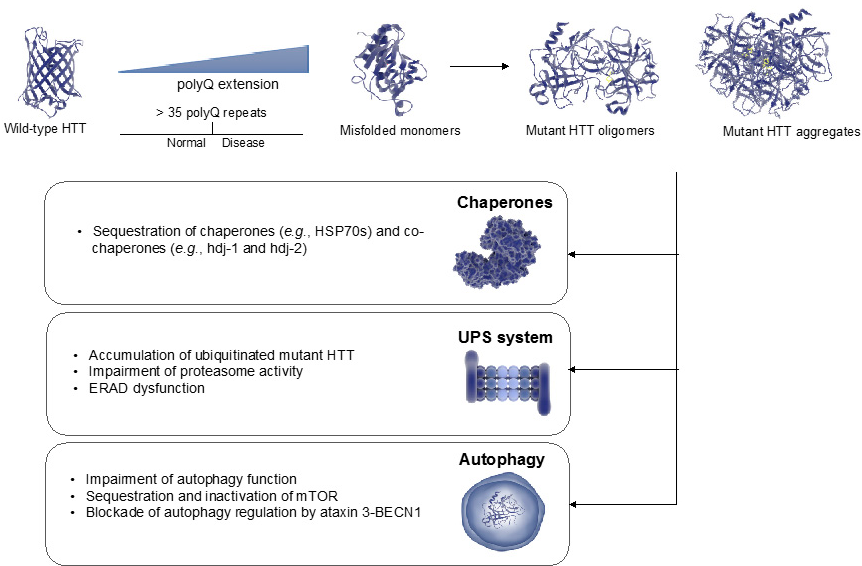
Figure 2. Proteostasis collapse induced by mutant HTT. When HTT contains more than 35 polyQ repeats, it aggregates and also forms toxic oligomers. The accumulation of polyQ-expanded aggregates and oligomers collapses distinct proteostasis nodes such as the chaperone network, the ubiquitin-proteasome system (UPS), endoplasmic reticulum-associated degradation (ERAD) and autophagy. Moreover, wild-type HTT act as a scaffolding protein directly involved in autophagy regulation whereas mutations in HTT can disrupt its normal function.